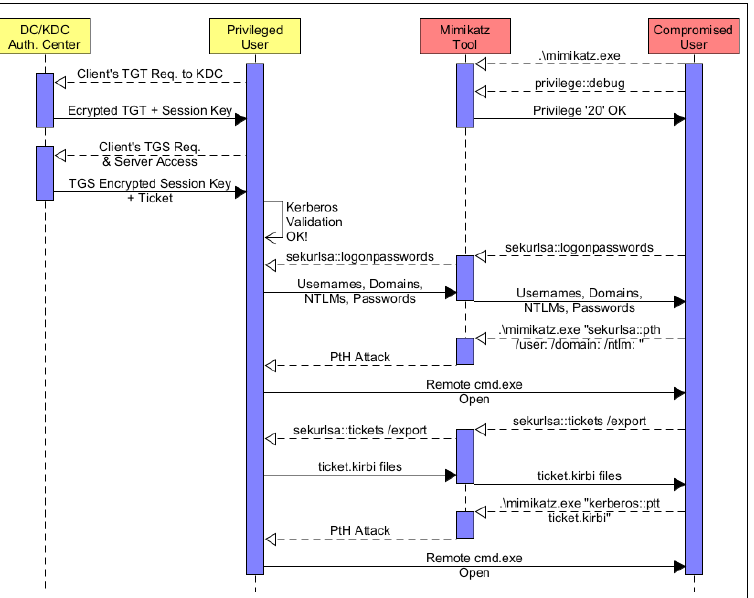
Figure 3. High-level view of Kerberos authentication procedure, along with the NTLM hash ex- traction vulnerability, that makes KDC prone to hashing exploitation attacks, namely PtH, PtT, and Golden/Silver